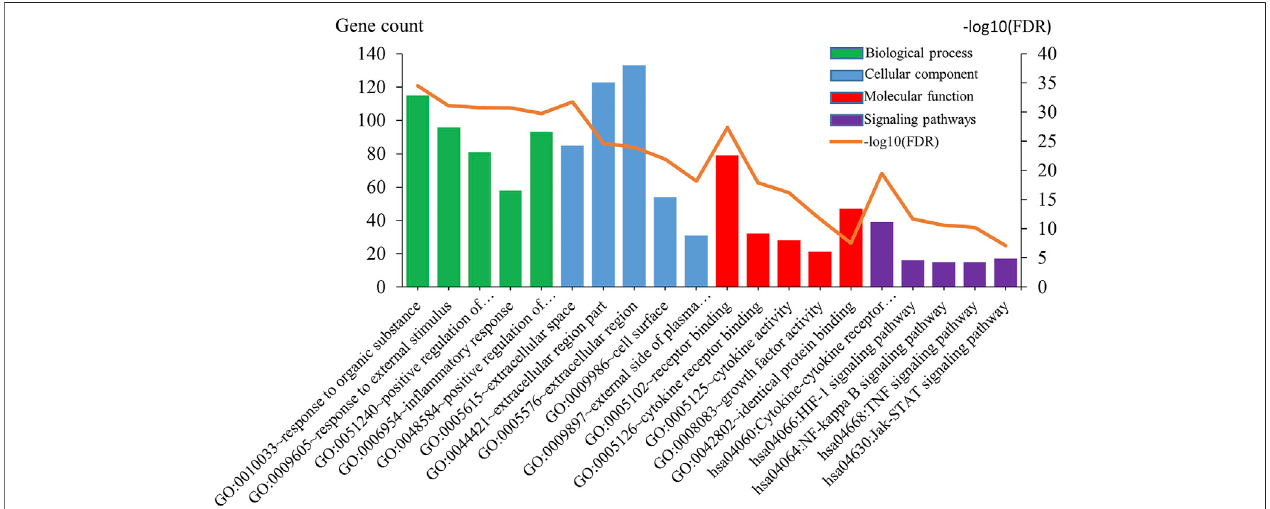
FIGURE 2 | Gene ontology and signal pathways analysis. Gene ontology analysis classi fi ed common genes into biological processes, cellular components, and molecular functions. Green bar charts represent the biological process, blue bar charts represent the cellular component, red bar charts represent the molecular function, purple bar charts represent the signaling pathways, and orange line chart represents − log10